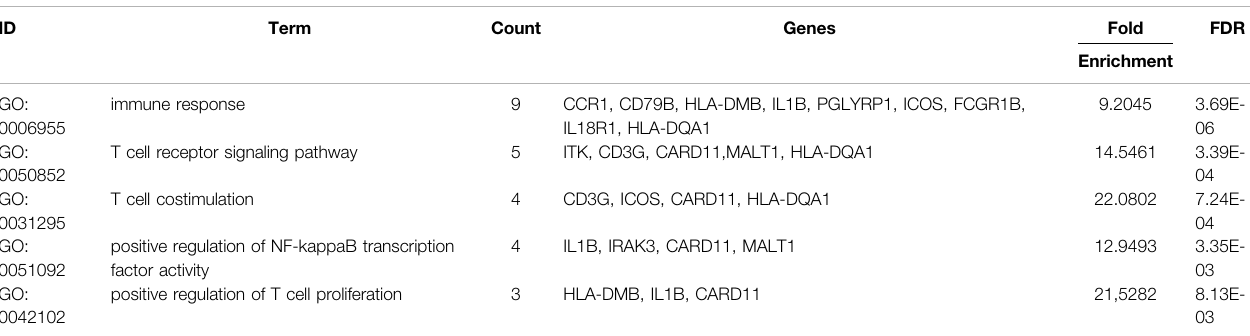
TABLE 5 | Top 5 GO terms (BP) of the 40 co-DEGs with the DAVID